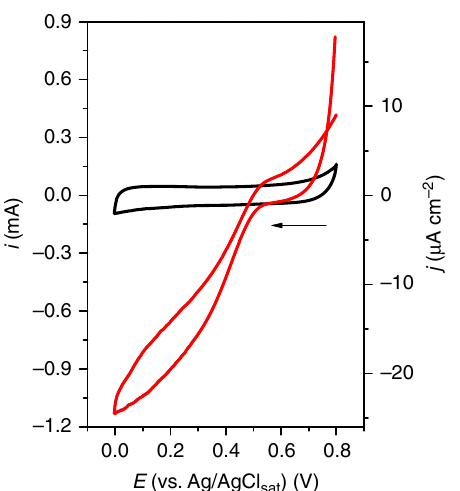
Fig. 2 Electrochemical ORR by Mv BOD. Cyclic voltammogram of Mv BOD- modi fi ed electrode in an (red line) O 2 -saturated electrolyte performing the ORR and (black line) Ar saturated showing no bioelectrocatalytic